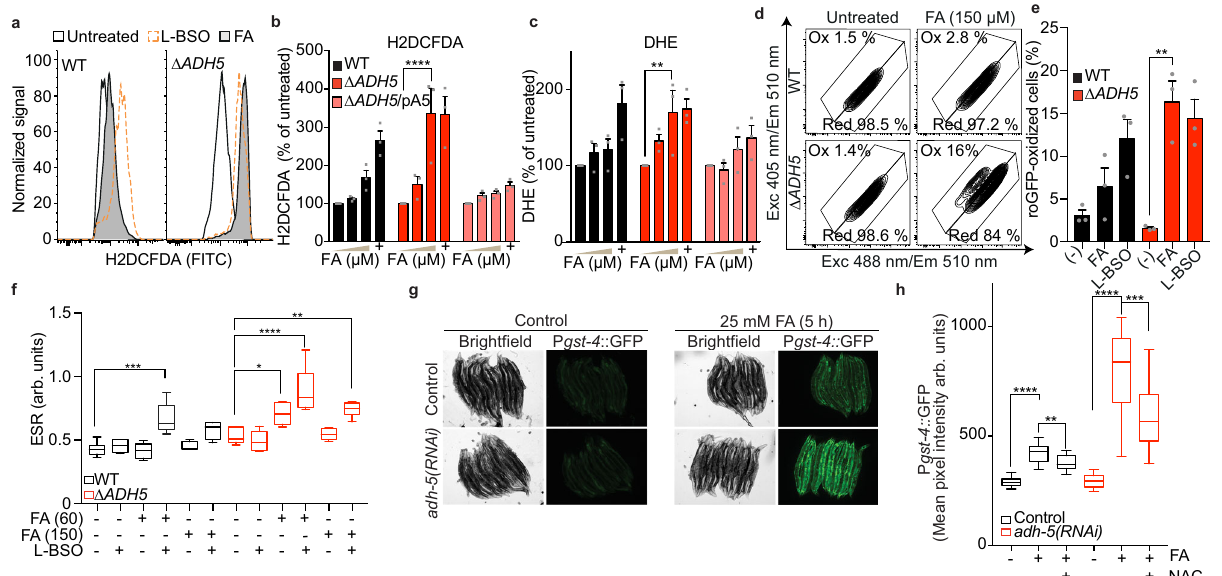
Fig. 3 Formaldehyde induces oxidative stress. Oxidative stress determination by 2 ′ ,7 ′ -dichlorodihydro fl uorescein diacetate (H2DCFDA) ( a , b ) and dihydroethidium (DHE) ( c ) in Wild type (WT), Δ ADH5 , and complemented Δ ADH5 ( Δ ADH5/ pA5) HCT116 cells upon 48 h exposure to 0, 60 and 150 μ mol L − 1 formaldehyde (FA). Data are presented as the % untreated mean ± SEM, n = 3, one-way ANOVA, Tukey´s multiple comparison test, **** P < 0.0001 ( b ), ** P = 0.0017 ( c ). µ M refers to µ mol L − 1 , mM refers to mmol L − 1 . The positive controls are 100 µ mol L − 1 L-buthionine sulfoximine (L- BSO) (48 h for H2DCFDA) and 10 µ mol L − 1 antimycin A (30 min for DHE). d Flow cytometry representative plots obtained from WT and Δ ADH5 HCT116 cells harbouring the cytoplasmic-roGFP reporter and exposed to 150 µ mol L − 1 FA for 48 h. e Quanti fi cation of experiments shown in ( d ) ( n = 3, mean ± SEM, one-way ANOVA, Tukey´s multiple comparison test, ** P = 0.0013). Positive control: The signal obtained incubating cells for 48 h with 100 µ mol L − 1 L-BSO. f Data showing Electron spin resonance (ESR) spectroscopy of reactive oxygen species (ROS) by the spin probe CMH (1-hydroxy-3- methoxycarbonyl-2,2,5,5-tetramethylpyrrolidine). Measures are from independent biological replicates exposed to the conditions stated in the fi gure for 48 h ( n = 6 except for Δ ADH5 ( − ), Δ ADH5 + 150 µ mol L − 1 FA, Δ ADH5 + 60 µ mol L − 1 FA + L-BSO, WT + 150 µ mol L − 1 FA and WT 60 µ mol L − 1 FA + L-BSO with n = 5), mean ± SEM, one-way ANOVA, Tukey´s multiple comparison test. WT: *** P = 0.0008; Δ ADH5 : * P = 0.0485 (( − ) vs FA (60)), ** P = 0.0065 (( − ) vs FA (60) + L-BSO), **** P < 0.0001. g Representative images of transgenic C. elegans expressing the transcriptional reporter P gst- 4 ::GFP upon 5 h exposure to 0 and 25 mmol L − 1 FA. The adh-5 plot refers to same strain carrying P gst-4 ::GFP, in which adh-5 expression was silenced by an speci fi c RNAi. h Boxplot with Tukey ’ s whiskers (1.5 inter-quartile distance, box centre at median, hinges at quartiles Q1 and Q3) depicting the quanti fi cation of mean pixel intensities of animals expressing P gst-4 ::GFP ( n = 25, two-tailed Mann Whitney test **** P < 0.0001, ** P = 0.0019, *** P = 0.0002). In the indicated groups, animals were co-incubated with 10 mmol L − 1 N-acetyl-L-cysteine (NAC) and 25 mM FA for 5